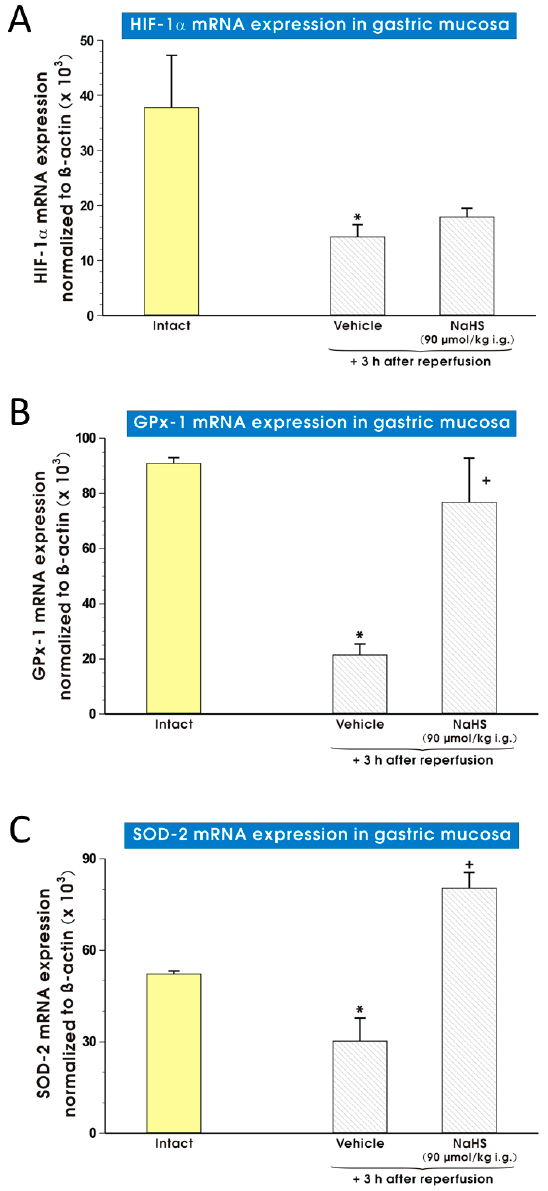
Figure 7. Expression of mRNA for HIF-1 α ( A ), GPx-1 ( B ) and SOD-2 ( C ) in gastric mucosa of rats exposed to I followed by 3 h of R and pretreated with vehicle (saline) or NaHS (90 μ mol/kg i.g.). Results are mean ± S.E.M of 4–5 rats per each experimental group. An asterisk indicates a significant change as compared with intact rats ( p < 0.05). A cross indicates a significant difference as compared with the vehicle pretreated group ( p < 0.05).